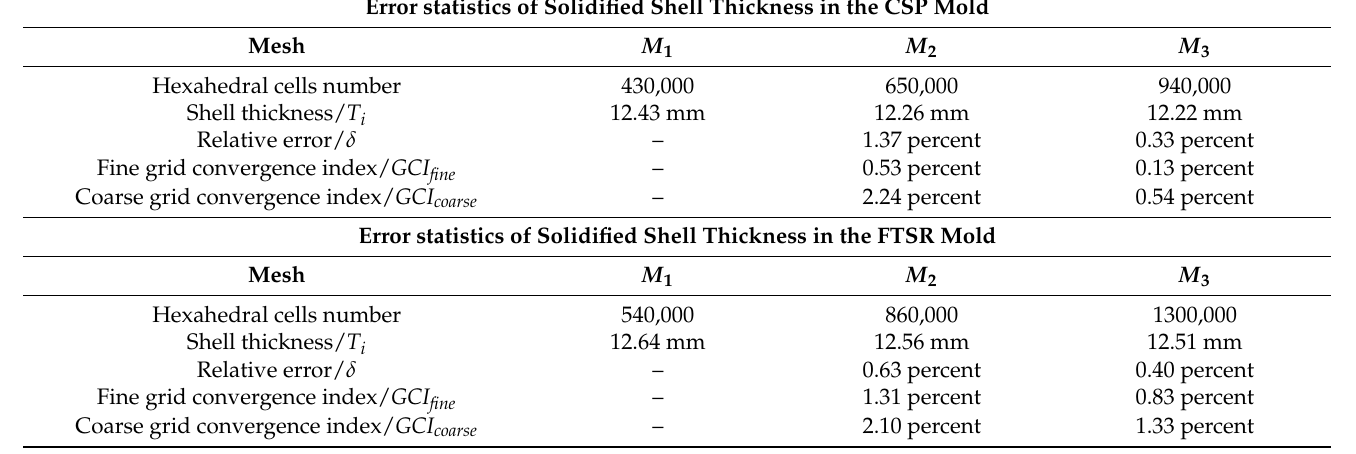
Table 2. Simulation error statistics of solidified shell thickness.